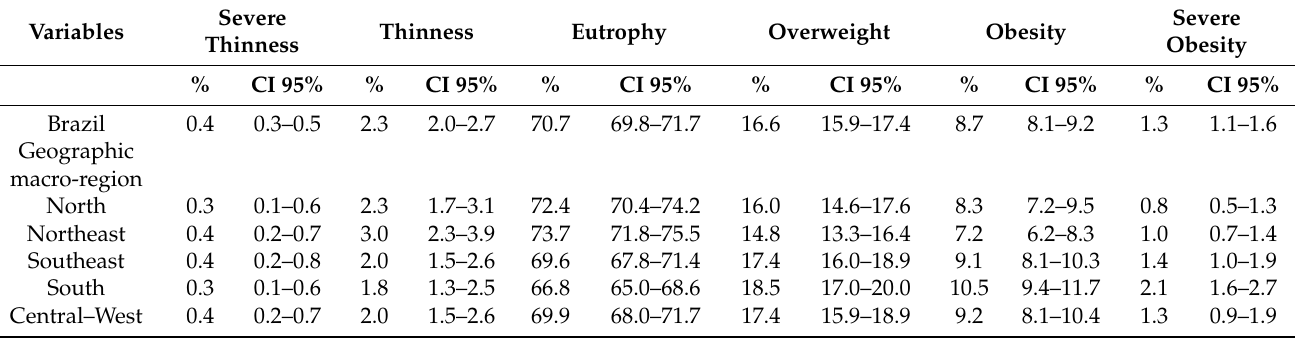
Table 1. Nutritional status prevalence among Brazilian adolescents, according to the BMI-age indicator and socio-demographic variables. National School Health Survey (PeNSE),